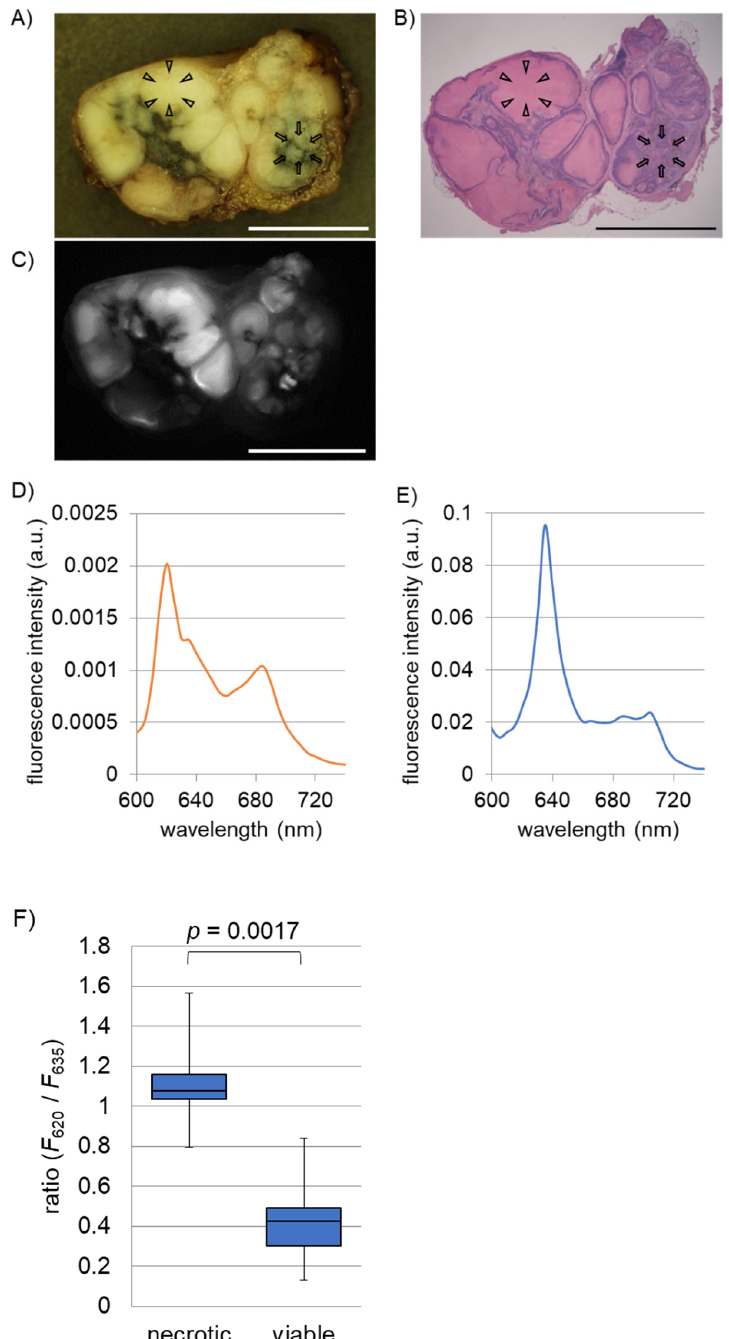
Figure 1. Fluorescence analyses of necrotic and viable tumor tissues of metastatic lymph nodes in esophageal cancer patients. 5-aminolevulinic acid (5-ALA) was orally administered prior to surgery. A total of 16 metastatic lymph nodes excised from eight patients were examined. Representative white-light ( A ), hematoxylin-eosin (HE) staining ( B ), and fluorescence spectroscopic ( C ) images of a metastatic lymph node with tumor necrosis. Note that necrotic (arrowheads) and viable tumor tissues (arrows) are observed. The fluorescence image was acquired at 640 nm. Scale bar, 5 mm. Representative fluorescence spectra of a necrotic tumor lesion ( D ) and viable tumor lesion ( E ). Fluorescence peaks at 620 nm in tumor necrosis and at 635 nm in living tumor are observed. ( F ) Box plot of ratio between fluorescence intensities at 620 nm and 635 nm of tumor necrosis and viable tumors. A significant difference in the ratio between tumor necrosis and viable tumor was indicated ( p = 0.0017).